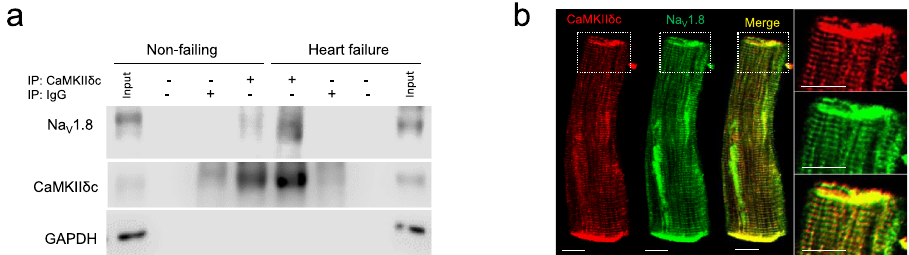
Fig. 1 CaMKII δ c interacts with Na V 1.8 in human myocardium and isolated cardiomyocytes. a Co-immunoprecipitation of CaMKII δ c and Na V 1.8 from left ventricular homogenates of human non-failing and failing hearts (NF: n = 7; HF: n = 7). b Co-localization of CaMKII δ c and Na V 1.8 in human failing cardiomyocytes with immuno fl uorescence staining. Scale bar: 10 µ m (staining was performed in cardiomyocytes isolated from fi ve heart failure